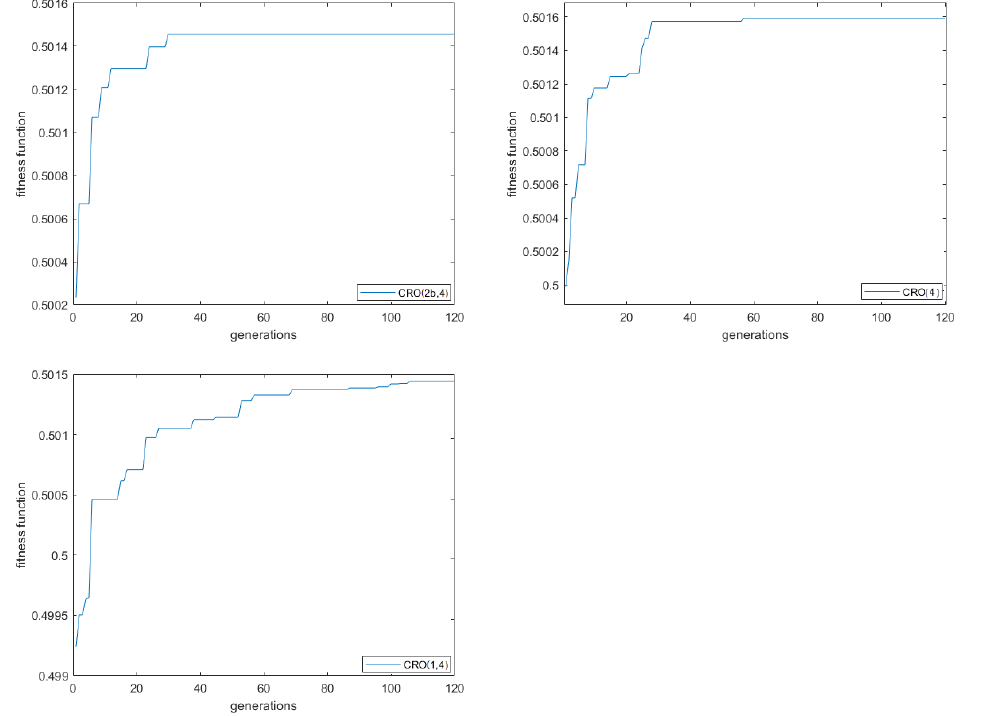
Figure 23. Best evolution’s obtained by CRO-SL algorithm with three different search